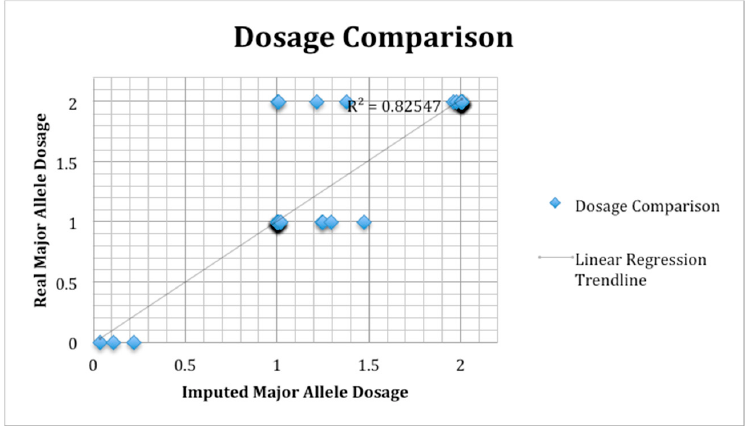
Figure 1 . SNP validation by Sanger sequencing. Plot of Sanger sequence minor allele dosage vs. the imputed minor allele dosage. A set of 57 samples (n = 25 cases and n = 32 controls) was chosen for validation using rs36067110 on 1p36.13 as a representative SNP. The overall correlation coefficient of imputed SNP dosage vs. Sanger sequence SNP dosage was 0.826.